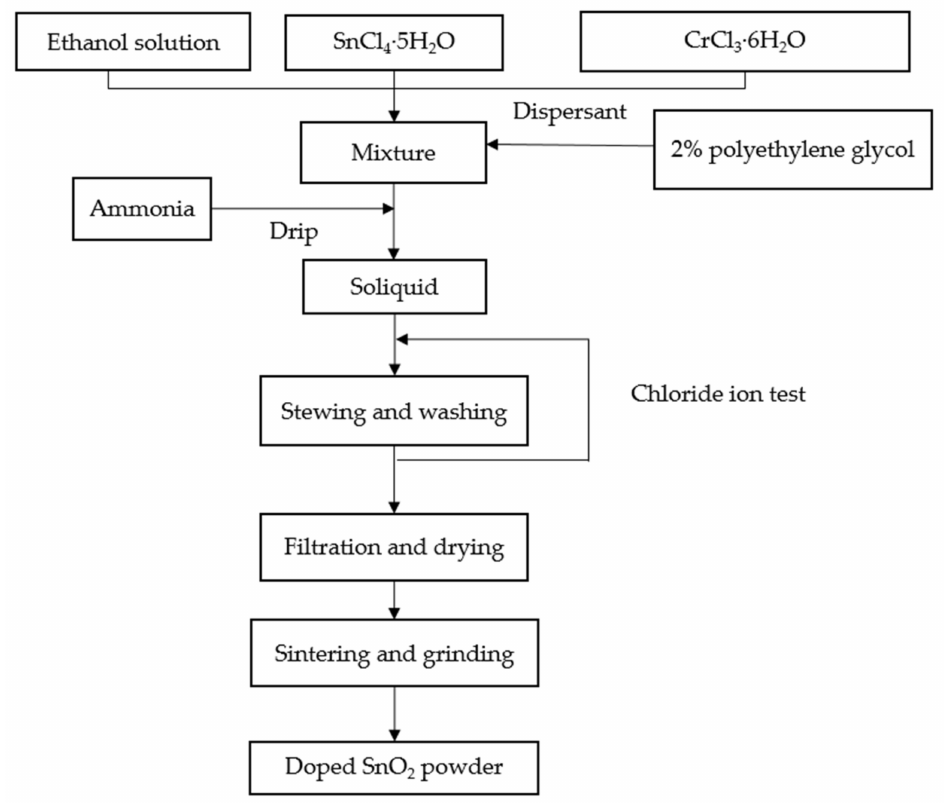
Figure 2. Process of doped SnO 2 powder preparation by sol-gel method. The Cr-doped AgSnO 2 contact materials were prepared using the high-energy ball milling and powder metallurgy method. This process is shown in Figure 3. The Ag powders and Cr-doped SnO 2 powders were weighed at a mass ratio of 88:12 and then mixed using the high energy ball milling technique (2 h). The agate balls used for grinding contained twenty balls Φ 10 − 2 m and 10 balls Φ 2 × 10 − 2 m. The ball to powder weight ratio was 15:1. The rounding speed of the ball mill was set as 500 r/min. The mixed powders were compressed into cylindrical samples with a diameter of 20 mm by 769YP-60E powder tablet press machine (Keqi New Technology Co., Ltd, Tianjin, China). The initial pressure was set at 10 7 Pa (17.6 tf) with 10 min kept. Then, the samples were put into the box-type electric furnace (SIOMM, Shanghai, China) for initial sintering (500 ◦ C, 90 min). In order to enhance compactness, the samples were recompressed (2 × 10 7 Pa, 10 min) and